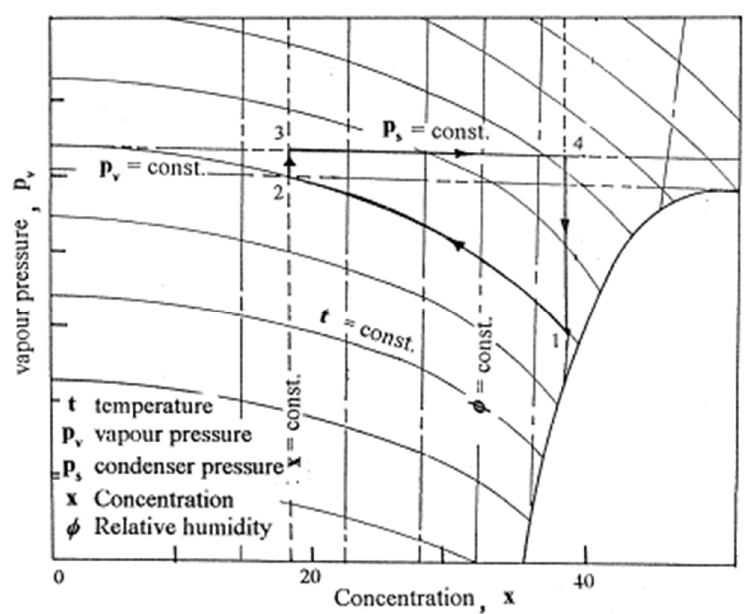
Figure 5. The absorption–regeneration cycle (adapted with permission from Reference [29], Copyright 2000, Elsevier).